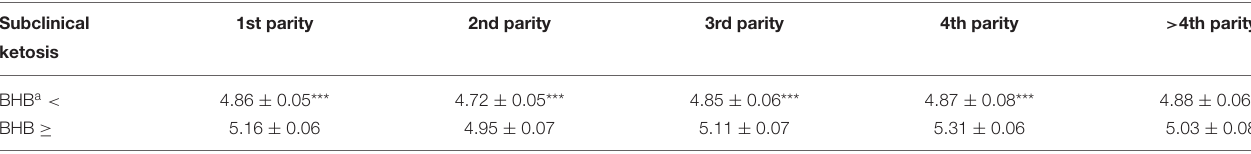
TABLE 4 | SCC (log 10 /ml) estimated means ( ± std.err.) classified by BHB values (threshold = 0.10 mmol/L) and parities resulting from HPMIXED analysis for repeated measurements (see Table 2 ). Subclinical